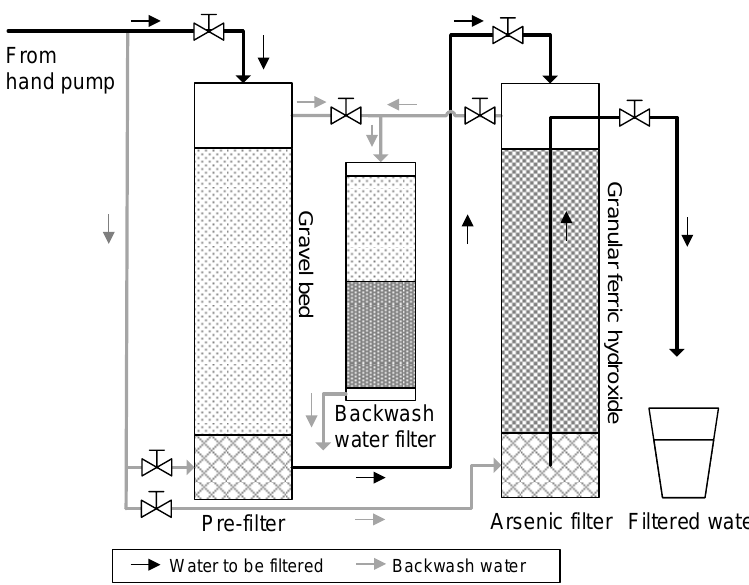
Figure 2. Scheme of a commonly applied ARP in West Bengal and Bangladesh (after [22]) [1].